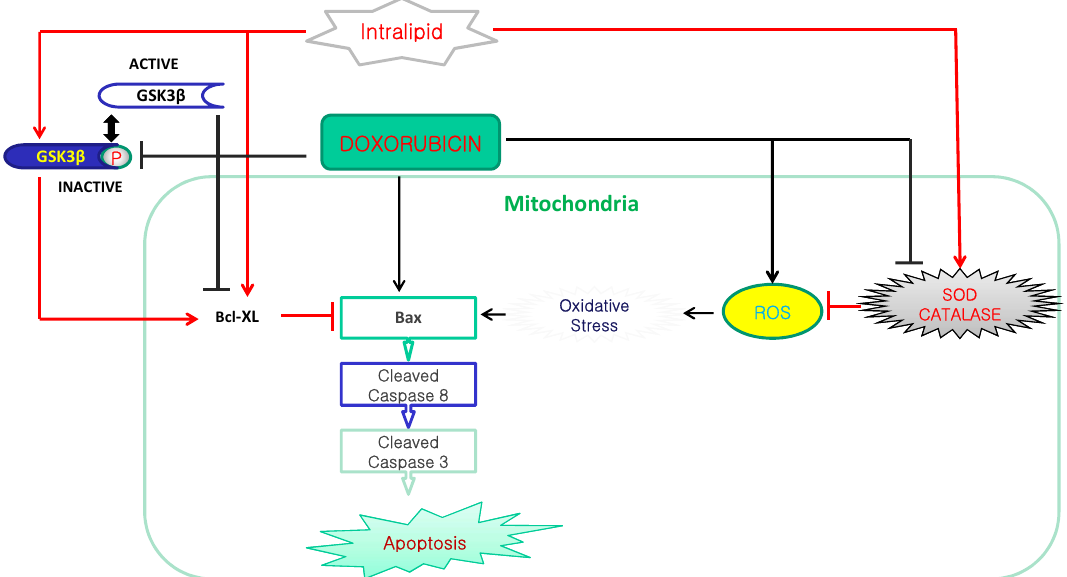
Figure 7. The putative cellular mechanism associated with the lipid emulsion (Intralipid ® )-mediated attenuation of apoptosis induced by a toxic dose of doxorubicin in H9c2 rat cardiomyoblasts. ROS: reactive oxygen species. SOD: Superoxide dismutase. GSK-3 β P: Phosphorylated glycogen synthase kinase-3 β